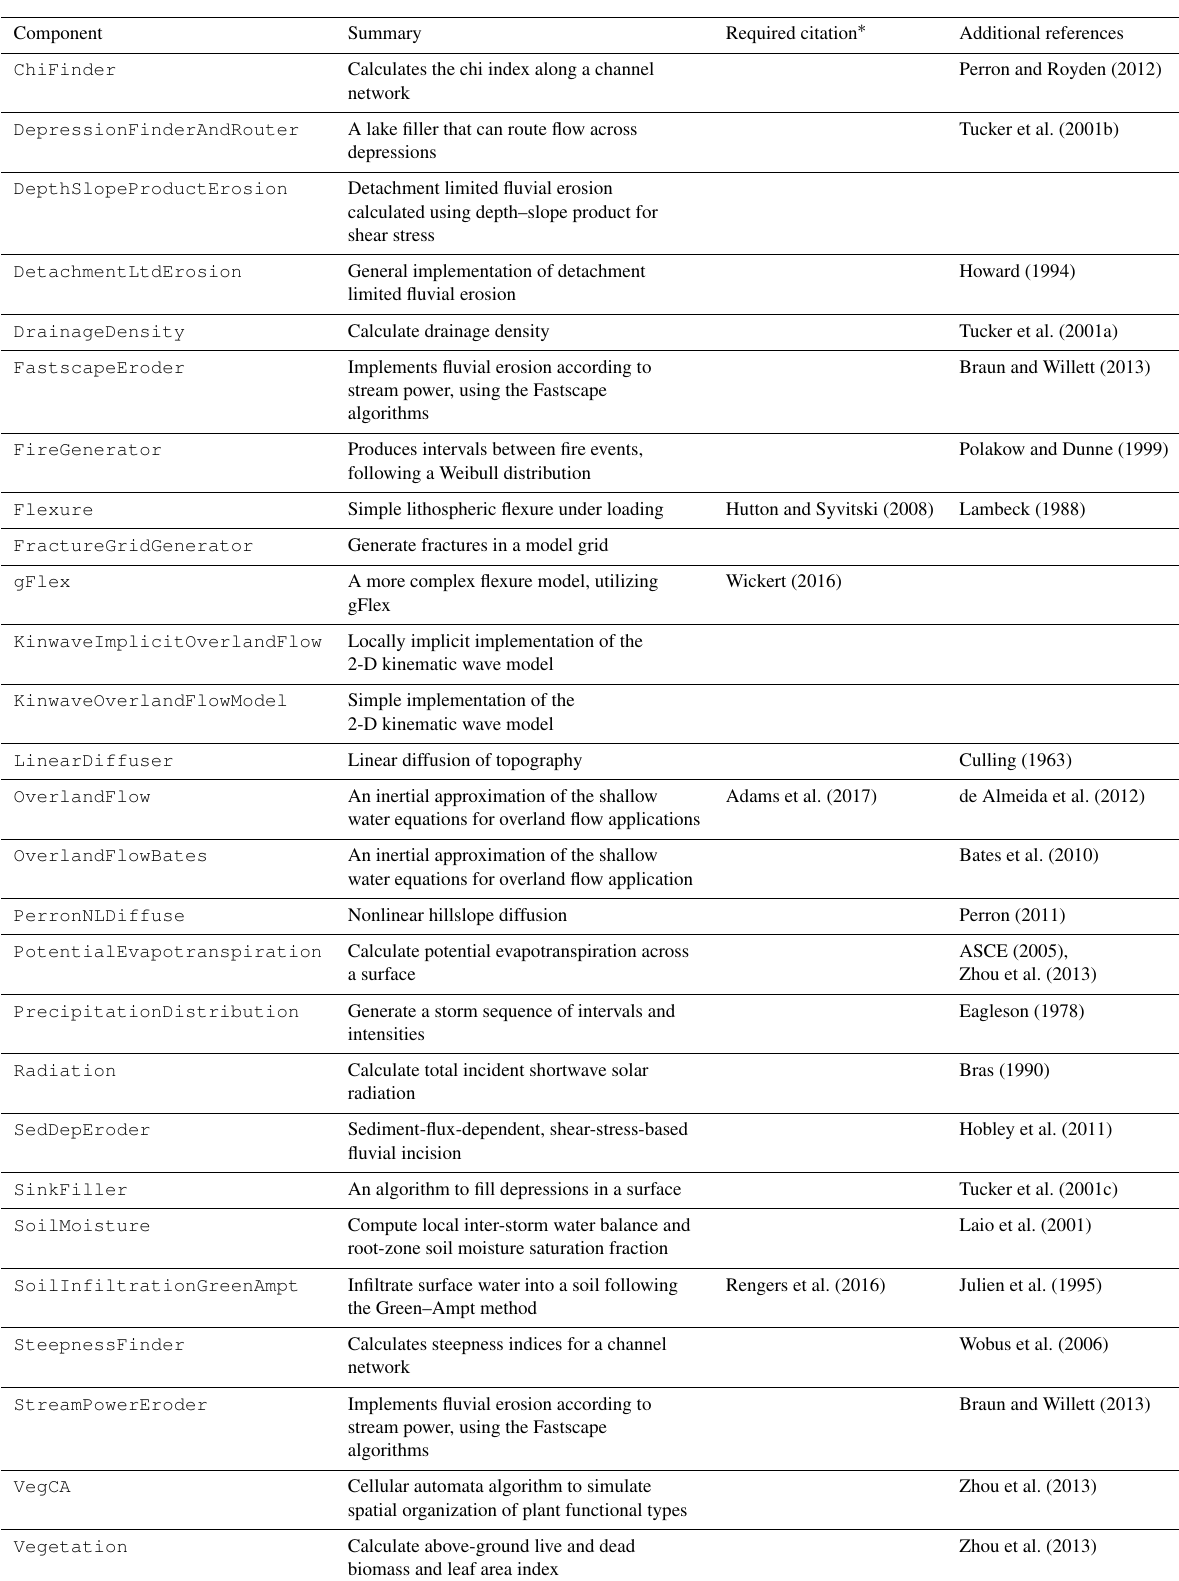
Table 4. Landlab components in v1.0 (after Hobley et al., 2017, their Table 5).